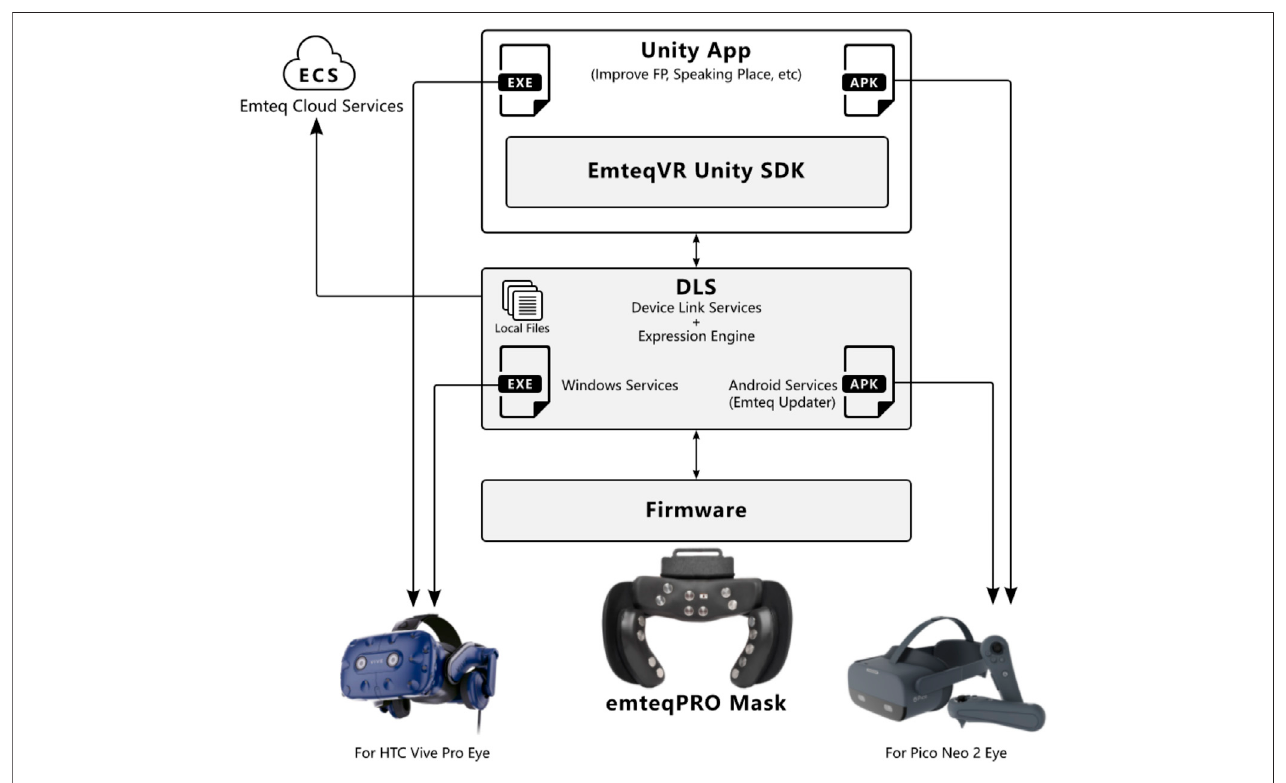
FIGURE 7 | emteqPRO software